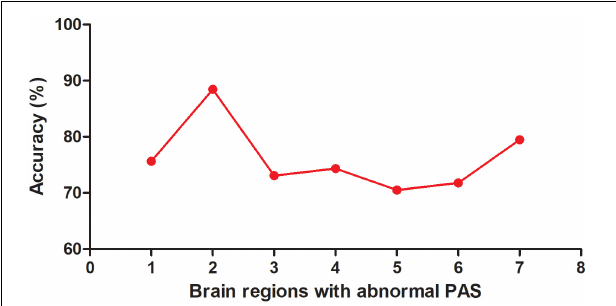
FIGURE 3 | Accuracy (%) of abnormal PAS scores in a single brain region to discriminate OCD from HCs. PAS, parameter of asymmetry; OCD, obsessive-compulsive disorder; HCs, healthy controls; 1, left cerebellum Crus I; 2, bilateral middle cingulate cortex; 3, left dorsolateral prefrontal cortex; 4, right inferior occipital gyrus; 5, left inferior parietal lobule; 6, left posterior cingulate cortex; 7, left precentral gyrus/postcentral